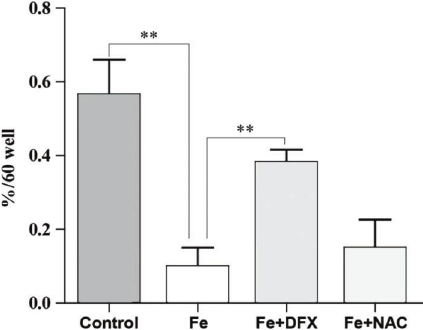
Figure 6. Clonogenic capacity of hematopoietic stem/progenitor cells (HSPCs) in iron overload (Fe) mice and after the adminis- tration of deferasirox (DFX) or N-acetyl-L-cysteine (NAC). Data are reported as means ± SD. **P o 0.01